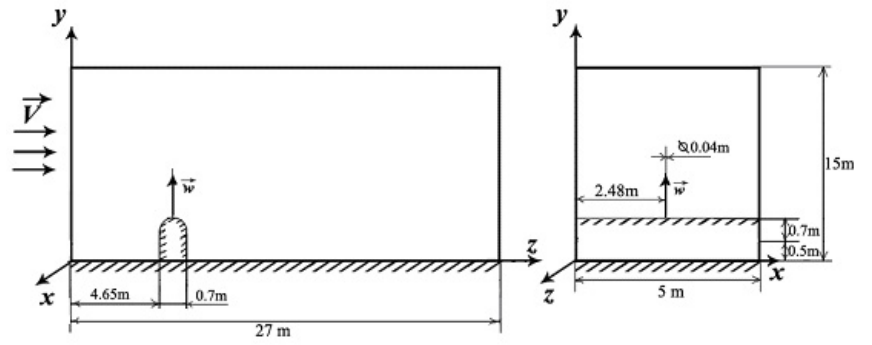
Fig. 7. Configuration with the deposit under the pipe: longitudinal view (along the ambient current); transversal view (along the diffuser).